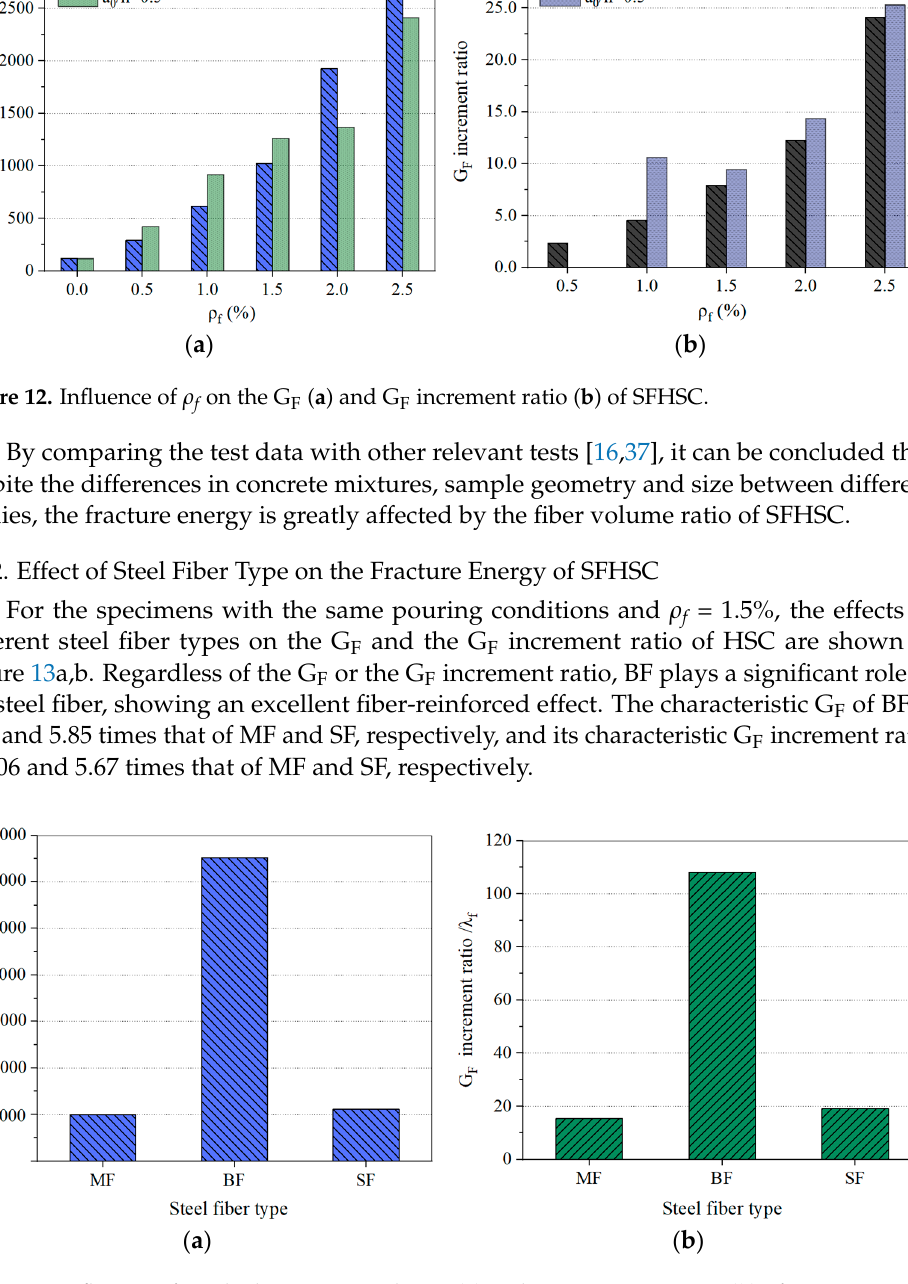
F ( a ) and G F Increment Ratio ( b ) of